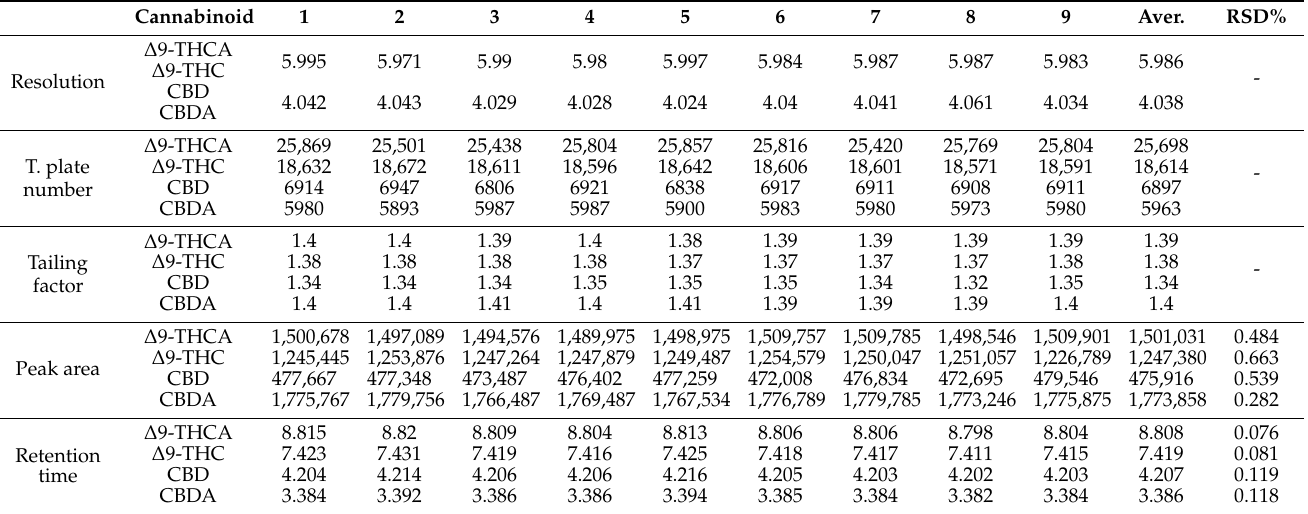
Table 1. Results of system suitability test ( n =